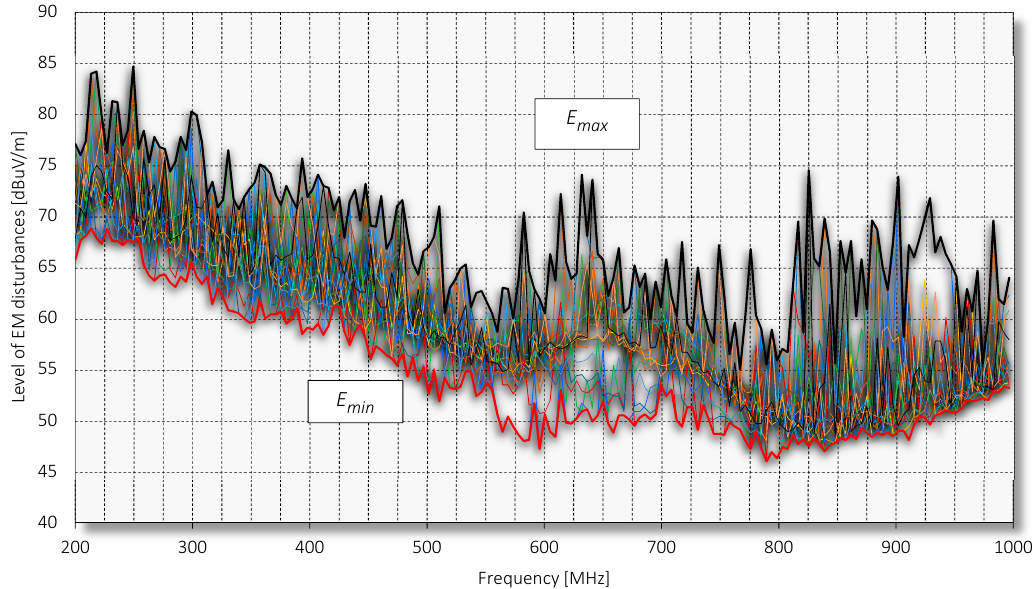
Figure 6. Levels of electromagnetic disturbances (valuable emissions, 15 measured devices of the same type) measured for laptops B in the range of frequencies from 200 MHz to 1 GHz, BW = 50 MHz, measurement distance: 1 m.